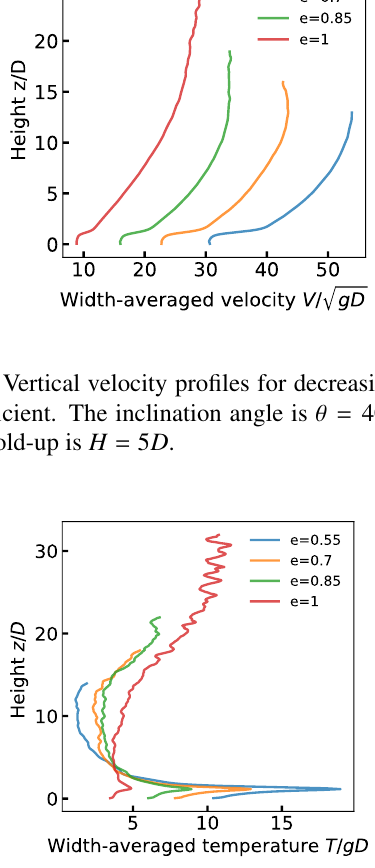
Figure 7: Vertical temperature profiles for decreasing restitution coe  cient. The inclination angle is ✓ = 40  and the particle hold-up is H = 5 D